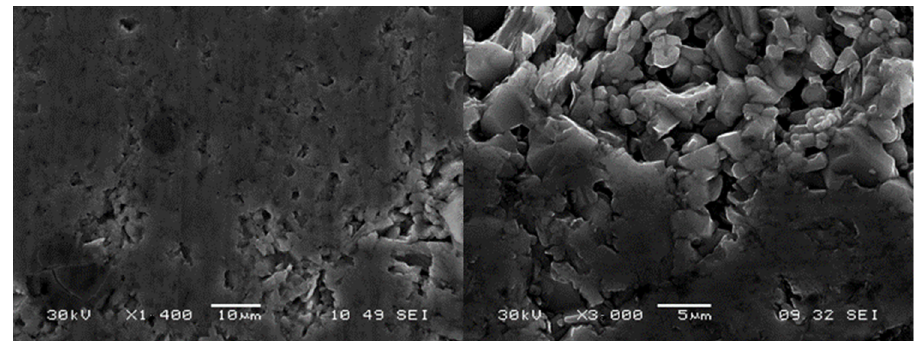
Figure 5. SEM images of the Ti 3 Al 1/3 Si 2/3 C 2 material surface. EDS spectra presented in Figure 6 show the intensities of the fluorescence lines of the constituent elements, which represent their relative content in the material. As can be expected, after normalization of the spectra to the maximum peak (Ti line), the silicon and alumina intensities grow/decrease with x . The example of a linear scan with EDS, shown in the insets, reveals an even distribution of elements, indicating good homogeneity of the material.